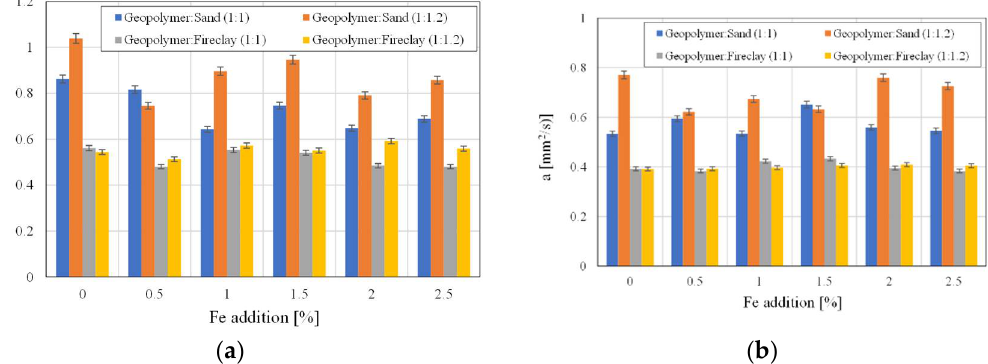
Figure 9. The thermal diffusivity values with regard to the used aggregates and the amount of added Fe: ( a ) before drying, ( b ) after drying.